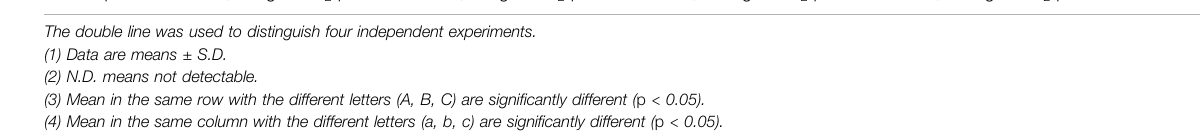
treatment. Table 7 indicates that, compared with the negative control, zeolite, OSP, and HA resulted in signi fi cantly less LMG in seawater; the removal rates are listed in Table 8 . As shown in Supplementary Figure S3 , the adsorption capacity of three water agents in LMG-containing seawater were calculated as following: